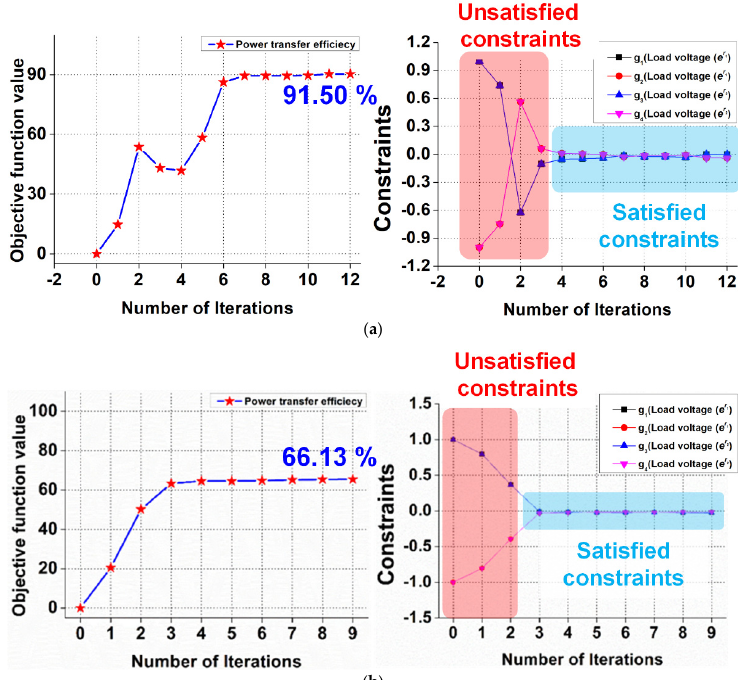
Figure A2. Optimized history for setting resonance for the S-M WPT systems with the air gap of 10 mm and 30 mm. ( a ) Air gap of 10 mm; ( b ) Air gap of 30 mm.